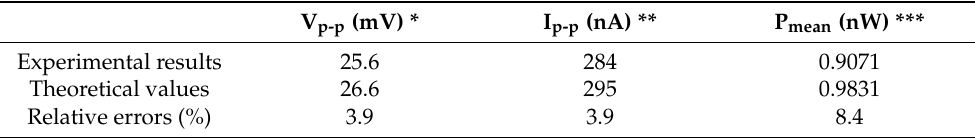
Table 5. Analytical and experimental results of the V p-p , I p-p , and P mean for partially covered cellulose-based piezoelectric energy harvester [79].